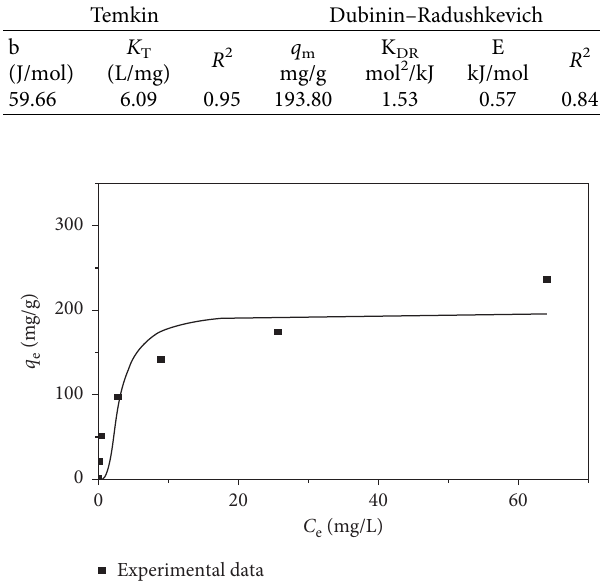
Figure 8: Nonlinear fit of the Dubinin–Radushkevich isotherm for MO adsorption onto activated carbon ( t contact � 2h; adsorbent dose � 1g/L; pH ∼ 7; T � 20 °